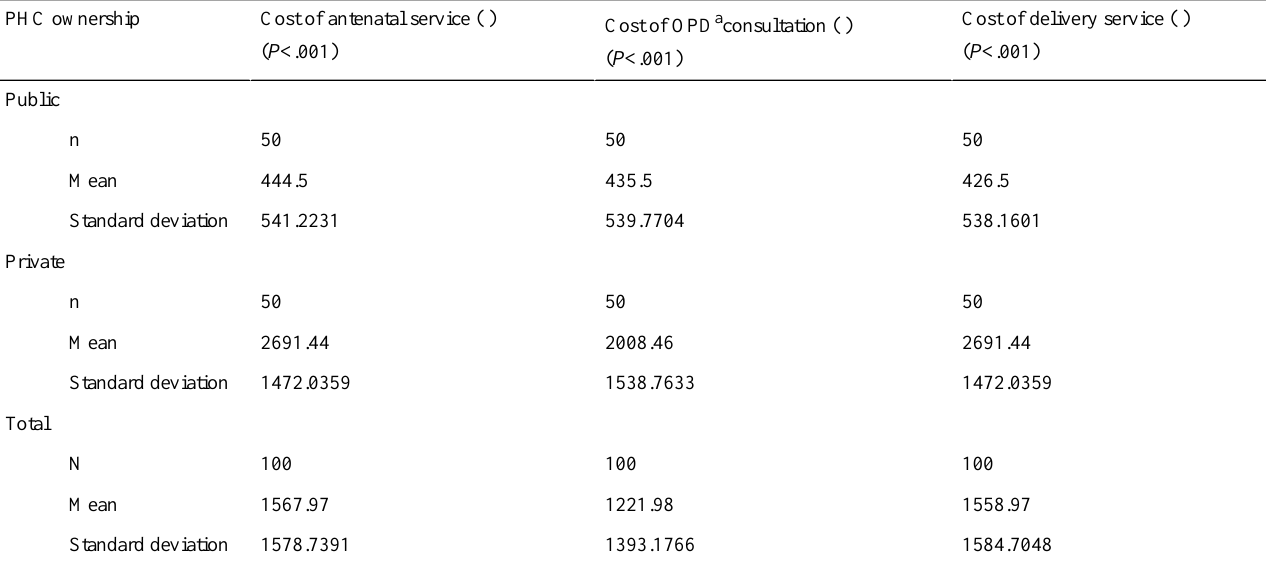
Table 3. Service costs as reported by health facility staff interviewed.